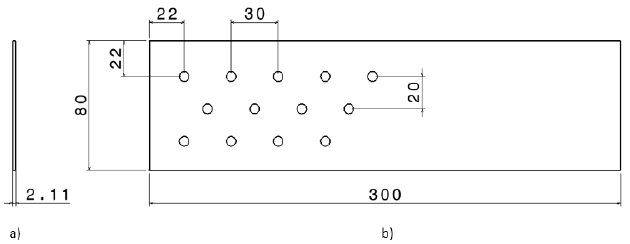
Figure 1. Measurements of the workpiece (mm) and test arrangement. ( a ) Side view. ( b ) Top view.